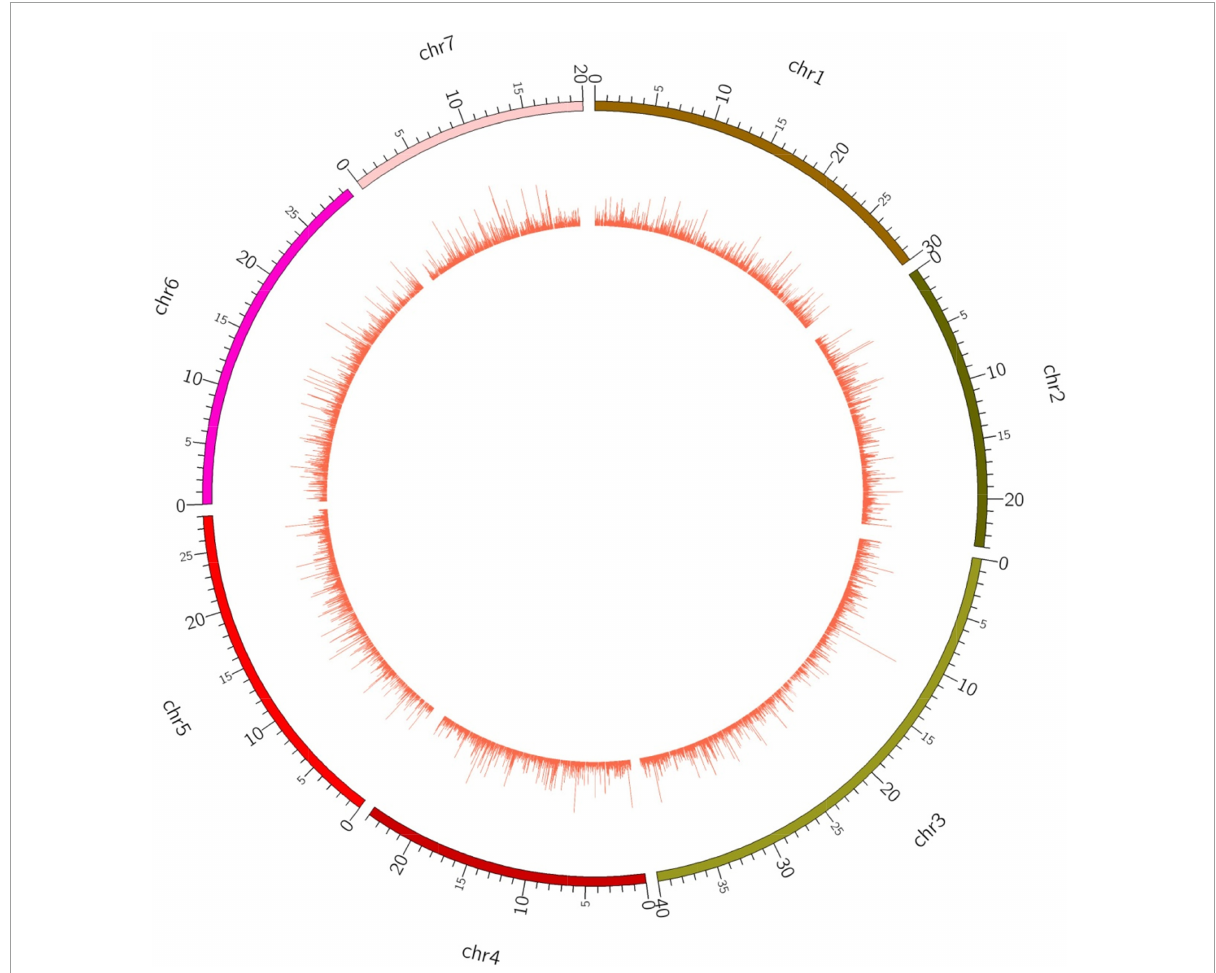
FIGURE3 Chromosome-wise distribution of identified lncRNA on cucumber